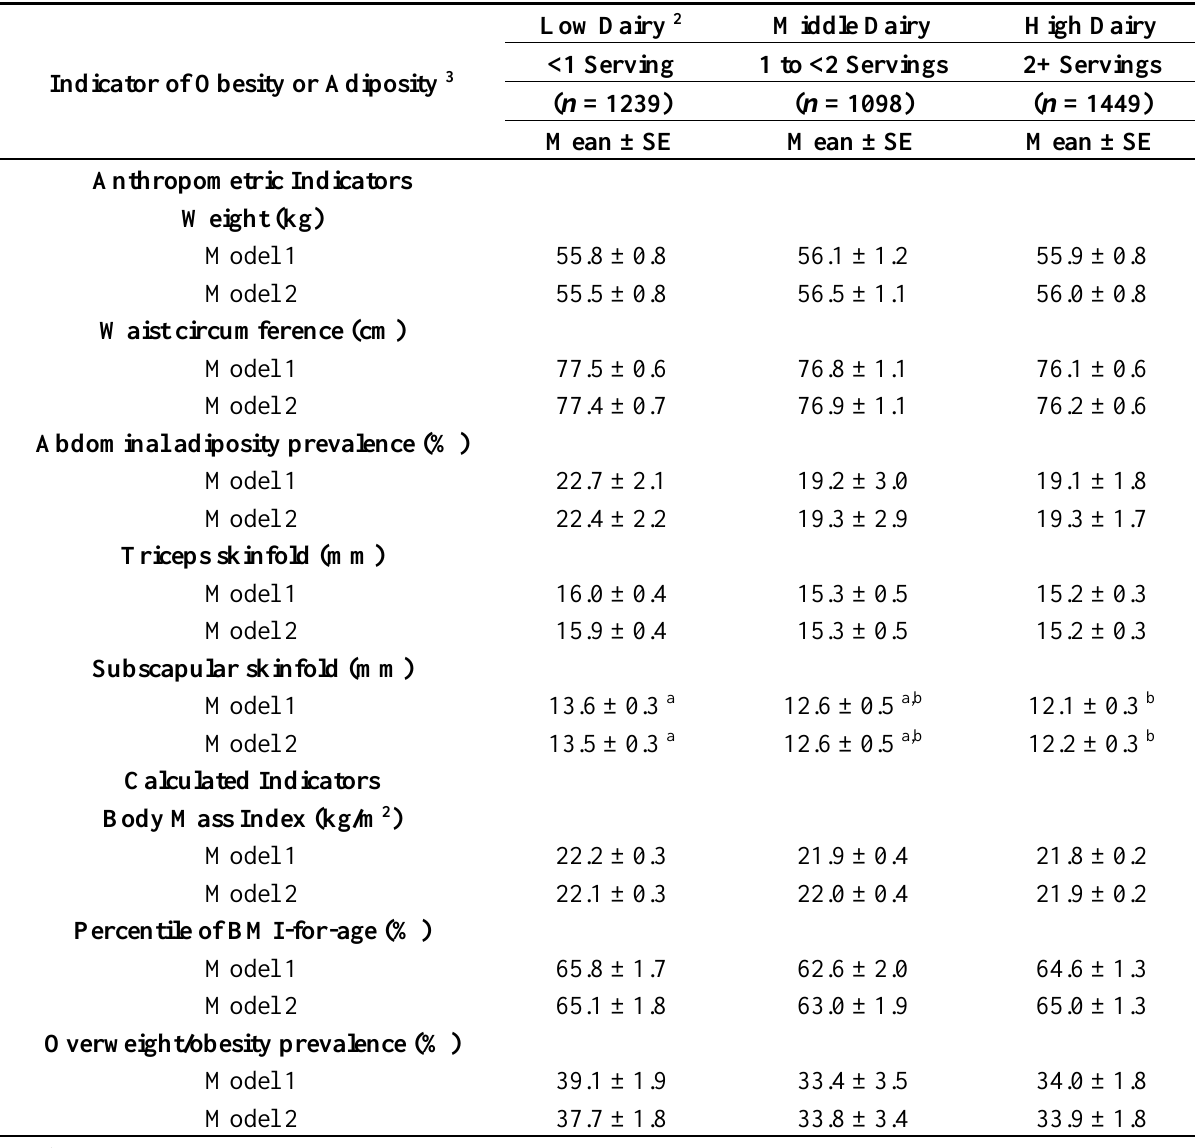
Table 4. Covariate-adjusted mean value of obesity or adiposity indicator by dairy consumption groups 1